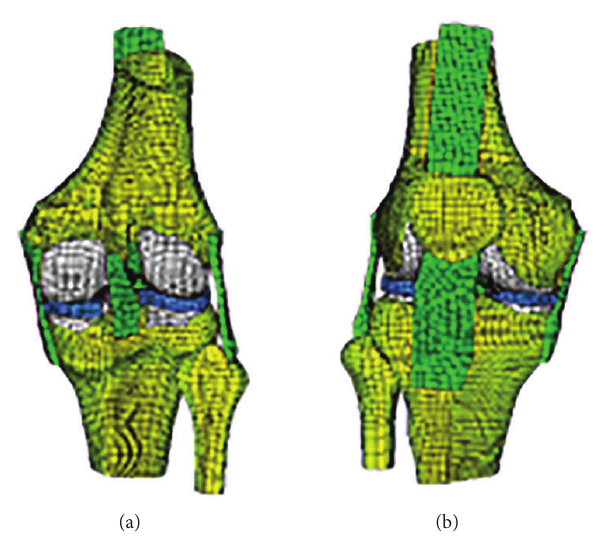
Figure 2: The FE model of knee.